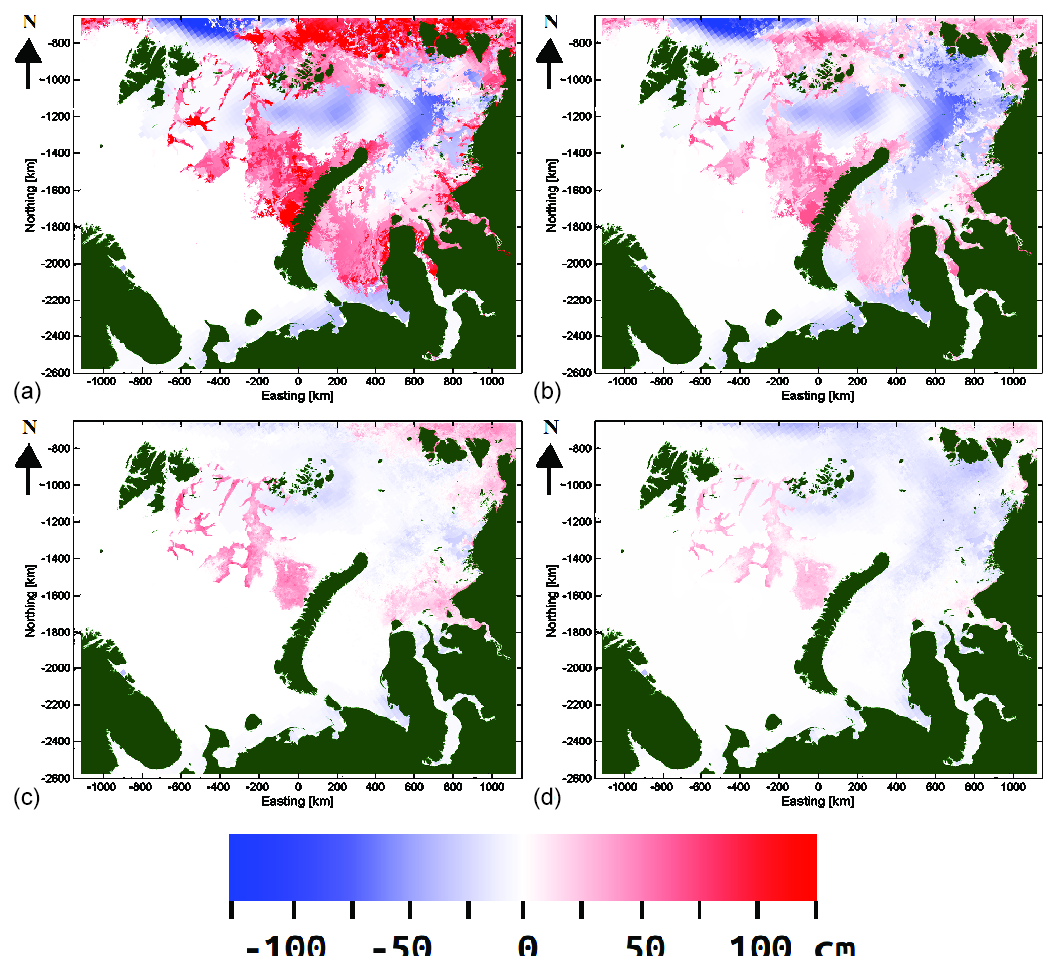
Figure 11. (a) Difference of the proposed (unmapped) SIT and CS2SMOS SIT for the 21 February 2017 case, (b) difference of the proposed remapped SIT and CS2SMOS SIT for the 21 February 2017 case, (c) average difference of the proposed (unmapped) SIT and the CS2SMOS SIT for the 2017 data, and (d) average difference of the proposed remapped SIT and the CS2SMOS SIT for the 2017